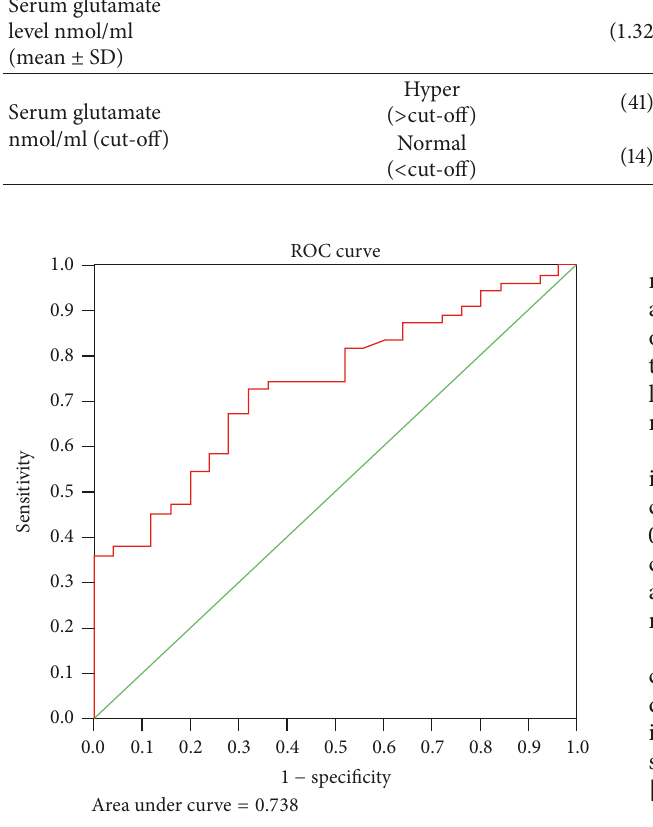
Figure 1: Cut-off value of serum glutamate (nmol/ml) (ELISA) that can differentiate between the patients and controls using the ROC